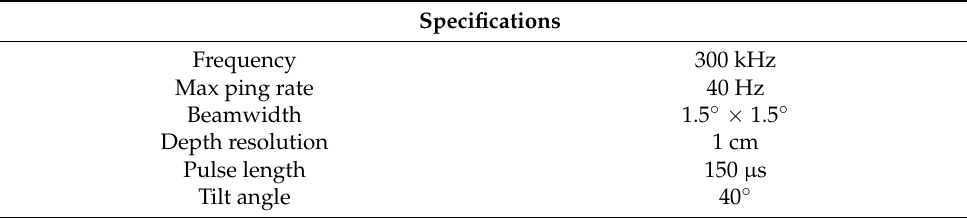
Table 2. Technical specification of the multibeam echo sounder EM